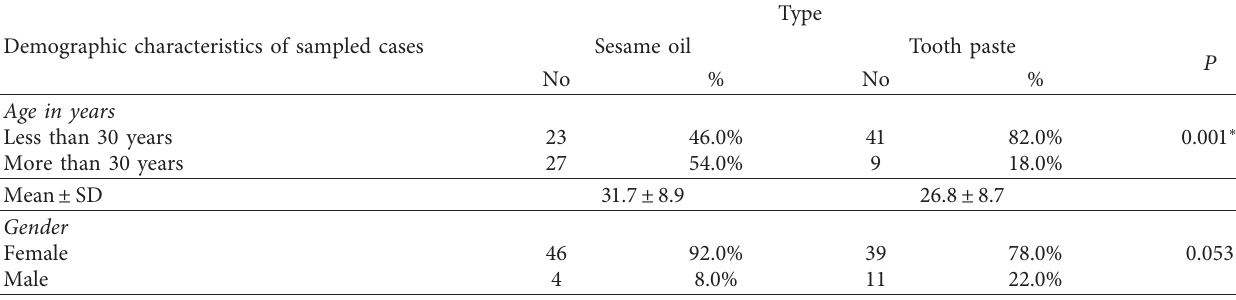
Table 1: Demographic characteristics of the sampled cases according to intervention type regarding